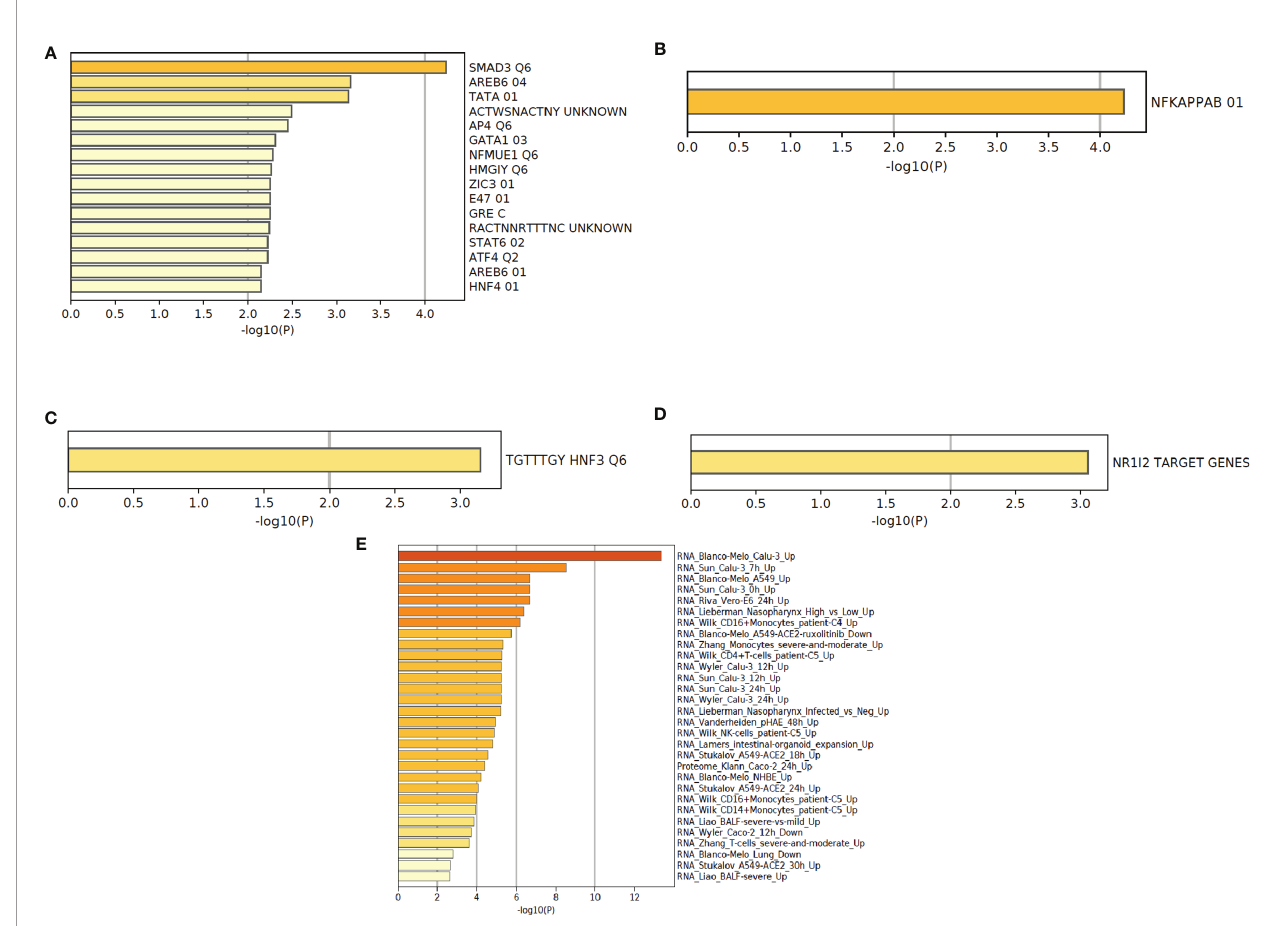
FIGURE 10 | The functional pathway enrichment analysis in transcription factor targets using protein-coding DEGs from our study and other studies. (A) Functional pathway enrichment analysis in transcription factor targets from the 250 DEGs of our study. (B) Functional pathway enrichment analysis in transcription factor targets with the top-ranked genes of the Xiong et al. study that used bronchoalveolar lavage fl uid sample. (C) Functional pathway enrichment analysis in transcription factor targets with the top-ranked genes of the Xiong et al. study that used PBMC samples. (D) Functional pathway enrichment analysis in transcription factor targets with the top-ranked genes of the Ziegler et al. study. (E) Functional pathway enrichment analysis in transcription factor targets with the top-ranked genes of the Jain et al.